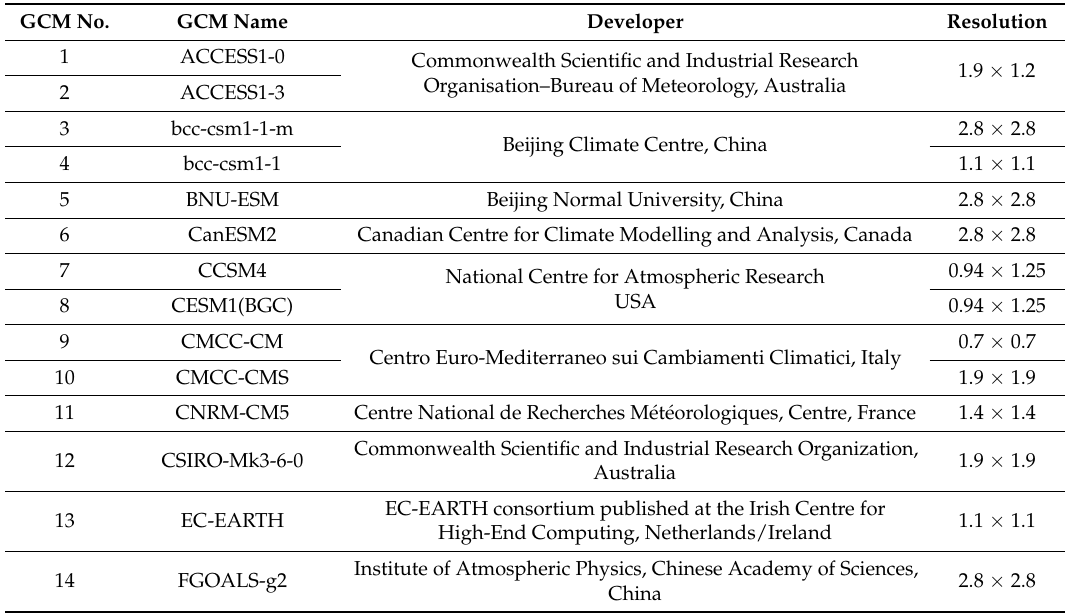
Table 2. The Coupled Model Intercomparison Project Phase 5 (CMIP5) general circulation models (GCMs) used in this study for the selection of an ensemble for